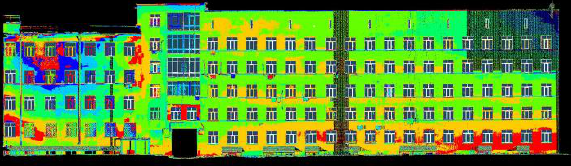
Figure 5 . 3D point cloud of the building façade.